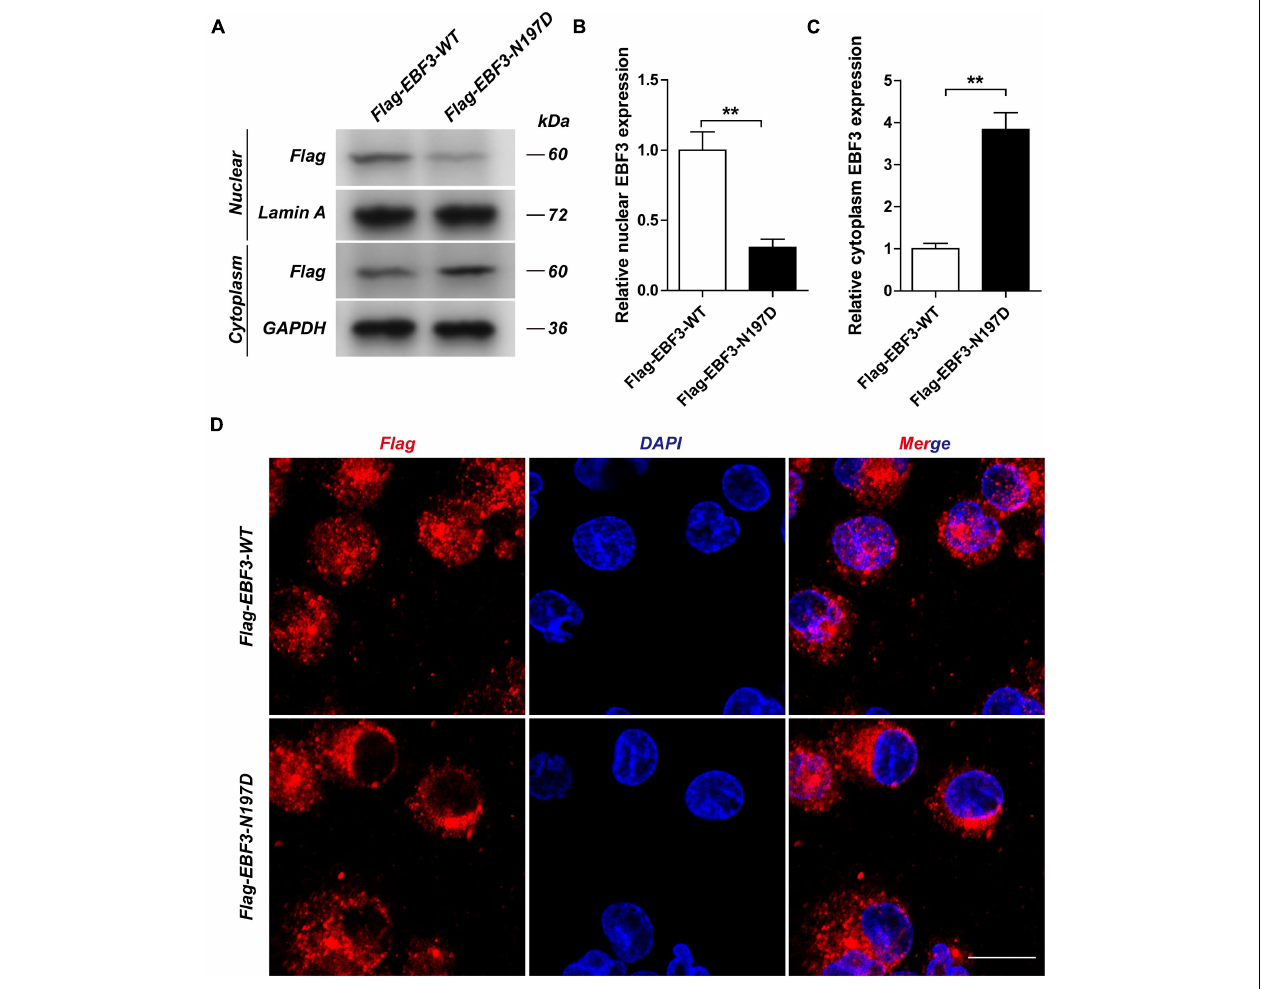
FIGURE 4 | The localization of Flag-EBF3-WT and Flag-EBF3-N197D in HEK293T cells. The distribution of p.N197D mutant was significantly reduced in the nucleus (A,B) , and increased in the cytoplasm (A,C) and affected its entry into the nucleus (D) . Results were mean ± SD for three individual experiments which, for each condition, were performed in triplicate. ** p <